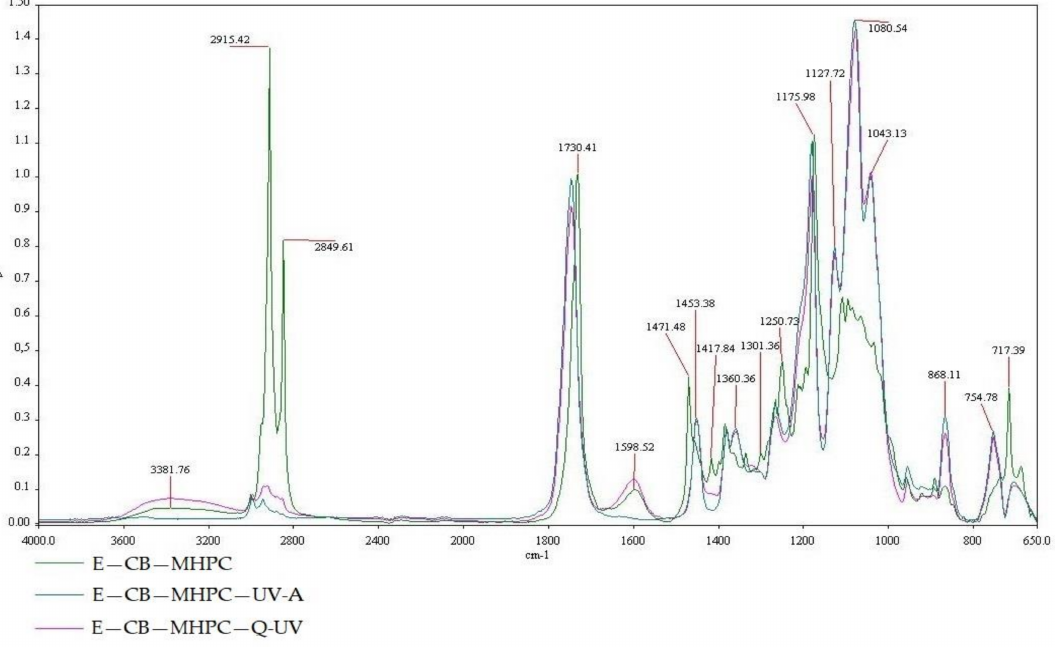
Figure 7. The FT-IR spectra of E—CB—MHPC, E—CB—MHPC—UV-A,